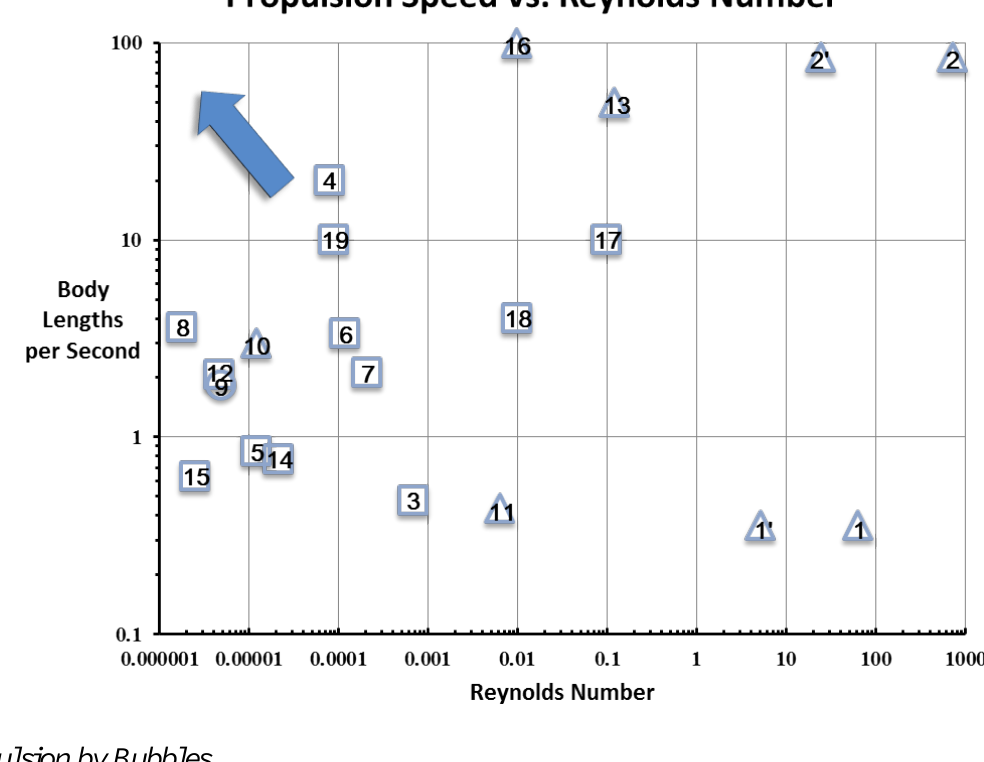
Figure 2. Propulsion speed and Reynolds number for artificial and natural micro swimmers. 1-acoustic scallop ( Re is based on body speed and size) [19], 1′-acoustic scallop ( Re is based on oscillating speed and amplitude), 2-oscillating micro bubble ( Re is based on body speed and size) [20], 2′-oscillating micro bubble ( Re is based on oscillating speed and amplitude), 3-artificial magnetic bacteria flagella [21], 4-artificial magnetic nanostructured propeller [22], 5-magnetically actuated colloidal [23], 6-magnetotactic bacteria propeller [24], 7-flagella-based propulsion [25], 8-active Brownian Janus [35], 9-self-motile colloidal [27], 10-catalytic nanomotor by bubble [28], 11-molecular motor [29], 12-striped metallic nanorod [32], 13-catalytic microtubular jet [30], 14-Pt-Au-Ppy motor with 1.05 μm radius cargo [33], 15-Au/Ni/Au/Pt-CNT motor with 4.3 μm diameter cargo [34], 16-Zinc microrockets [31], 17-paramecium [17], 18-human spermatozoon [17], and 19- Escherichia coli [18]. Note that the triangles denote inertia dominant propulsion, the squares denote viscous dominant propulsion, and the circles means the propulsion mechanisms cannot be clearly